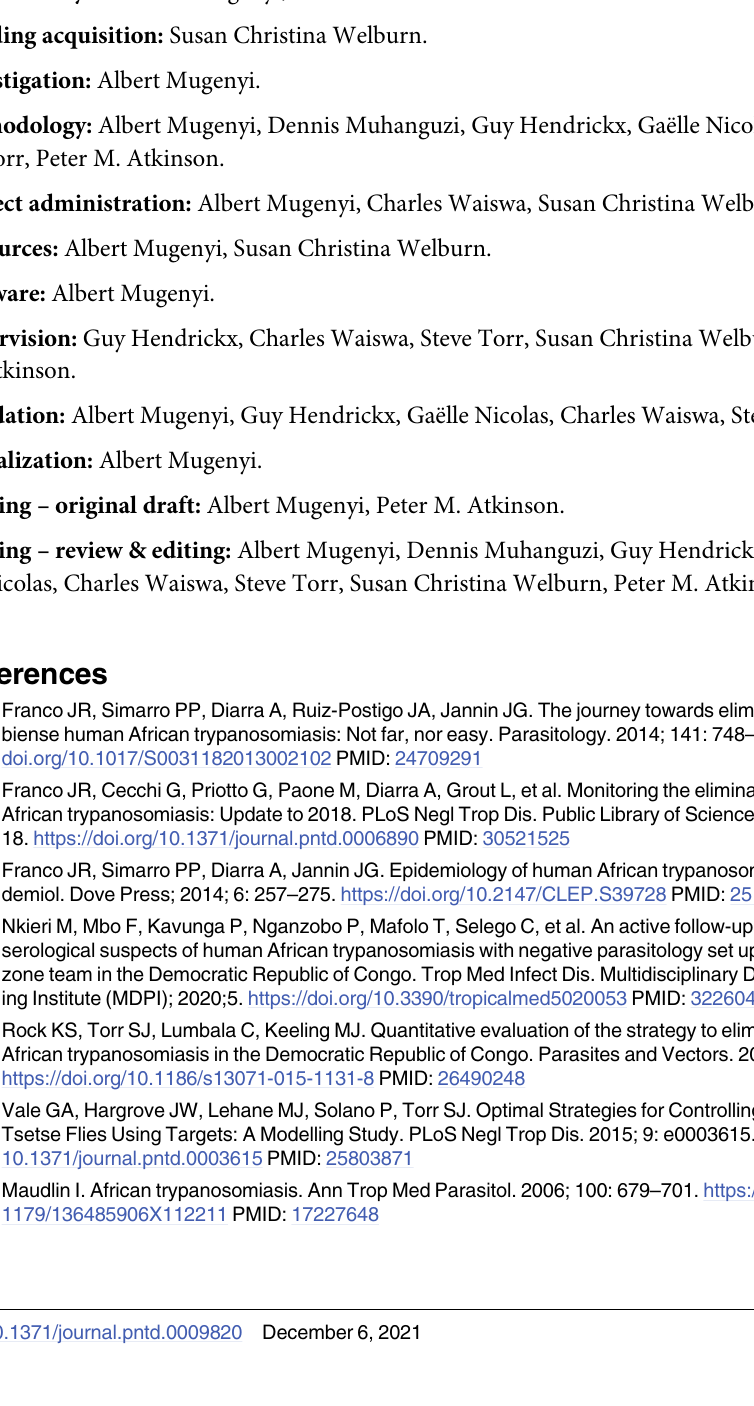
S1 Protocol of data abstraction. Tsetse